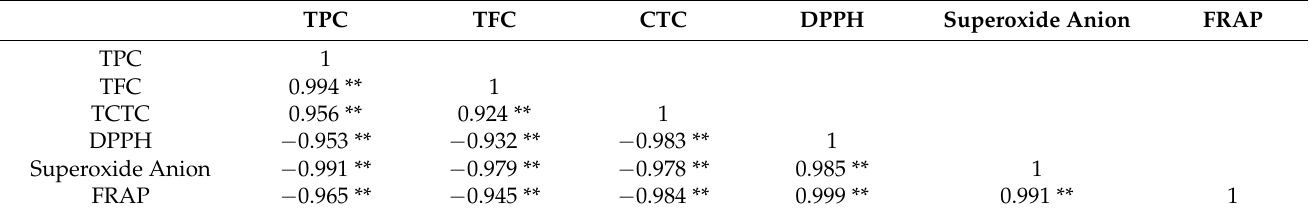
Table 4. Pearson’s Correlation.